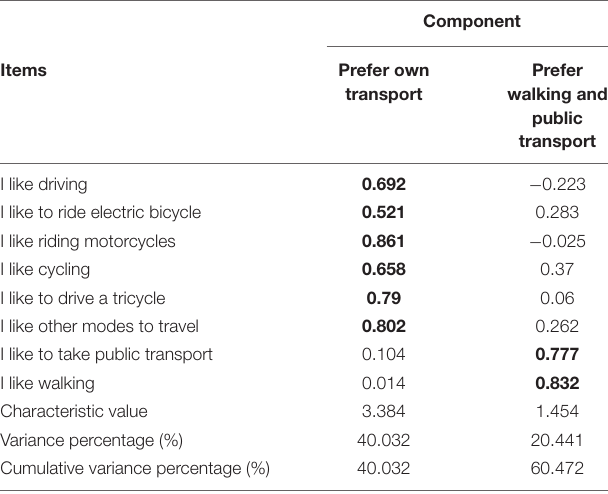
TABLE 6 | Travel mode preference: component matrix after rotation.